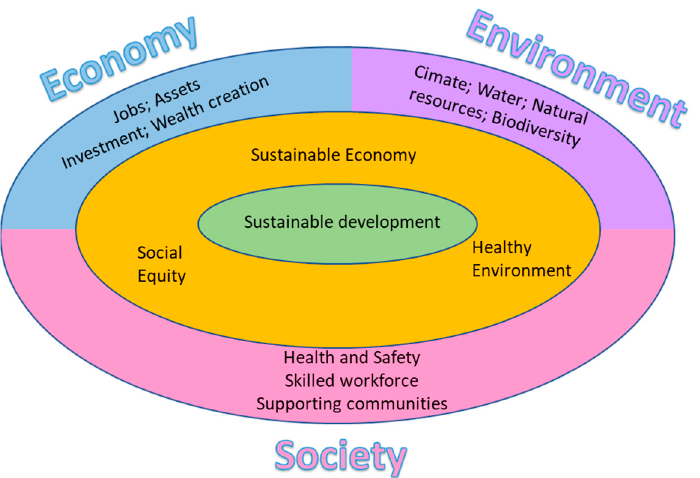
Figure 1. The three pillars of sustainable development, adapted with permission from Millard et al. (2016) [12].